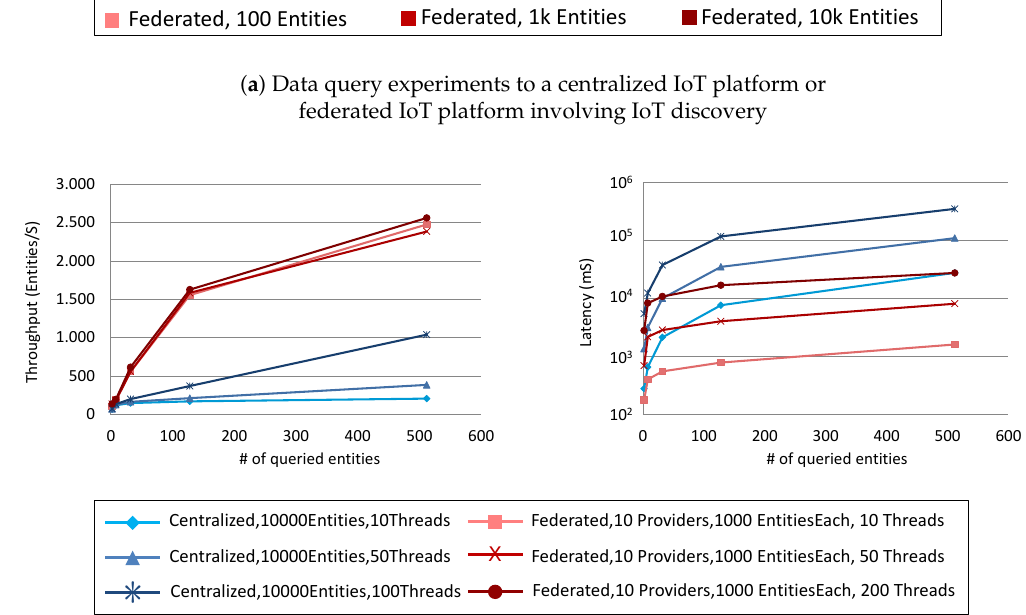
Figure 8. IoT platform experiments: ( a ) performance impact of the federation of IoT platforms; ( b ) scalability of IoT platforms’